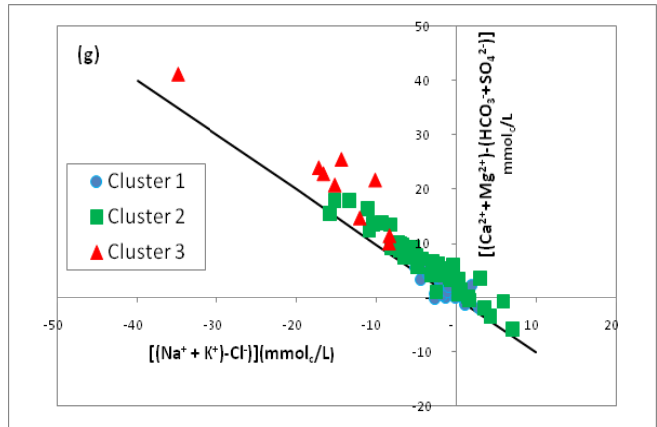
Figure 9. Bivariate plots of ( a ) (Ca 2+ + Mg 2+ ) versus HCO 3 − , ( b ) (Ca 2+ + Mg 2+ ) versus (HCO 3 − + SO 42 − ), ( c ) (Ca 2+ + Mg 2+ ) versus (Cl − + SO 42 − ), ( d ) Na + /Cl − versus Cl − , ( e ) (Ca 2+ + Mg 2+ ) versus Cl − , ( f ) HCO − /(Cl − + SO 42 − ), and ( g ) [(Na + + K + ) − Cl − ] versus [Ca 2+ + Mg 2+ ) − (HCO − 3 + SO 42 −